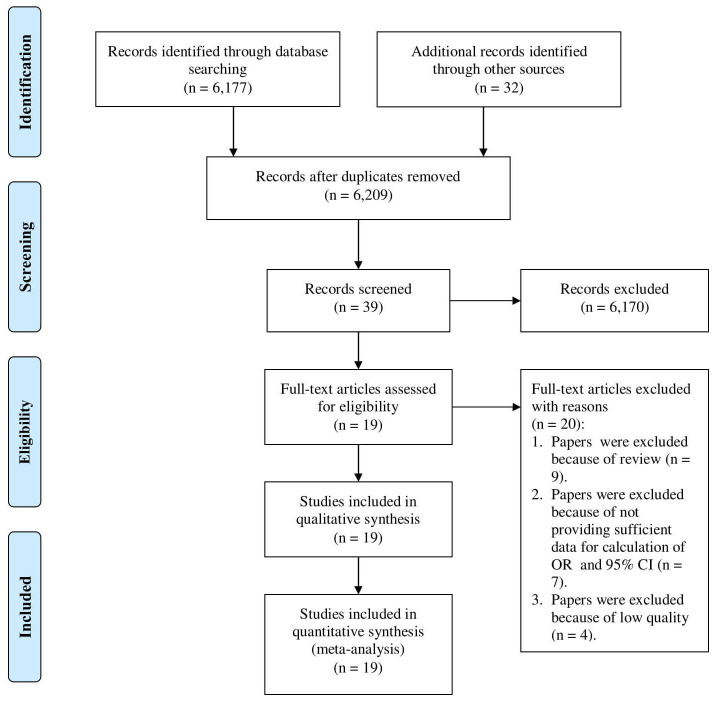
A flowchart of paper selection in our study.